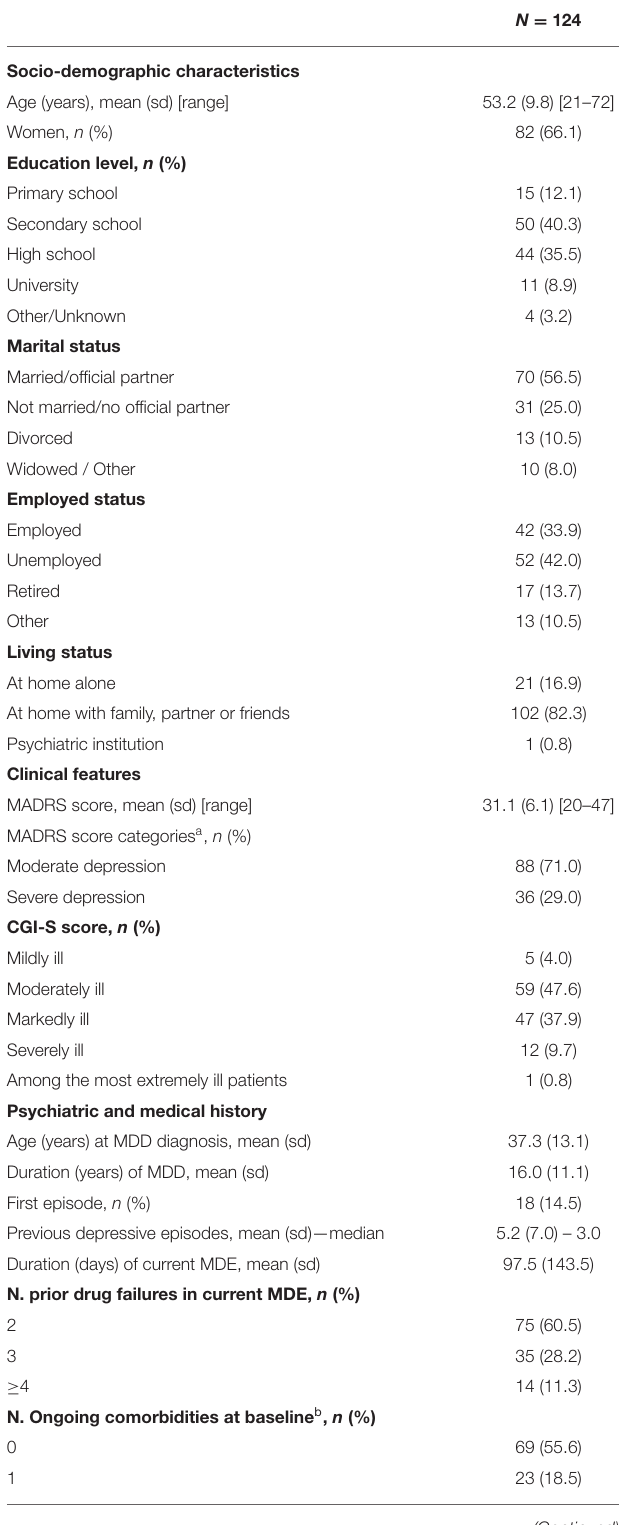
TABLE 1 | Baseline socio-demographic characteristics and clinical features, psychiatric and medical history of patients with treatment-resistant depression